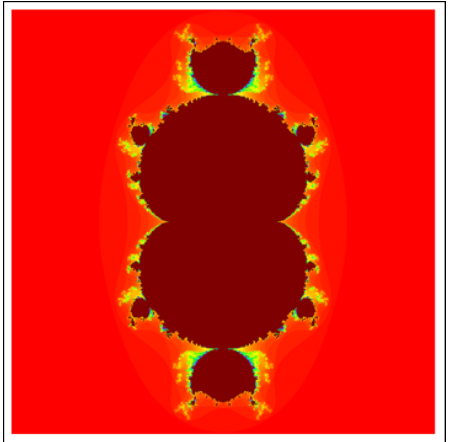
Figure 27. M-set of third degree via F-iteration with image visual time = 95.9 s.